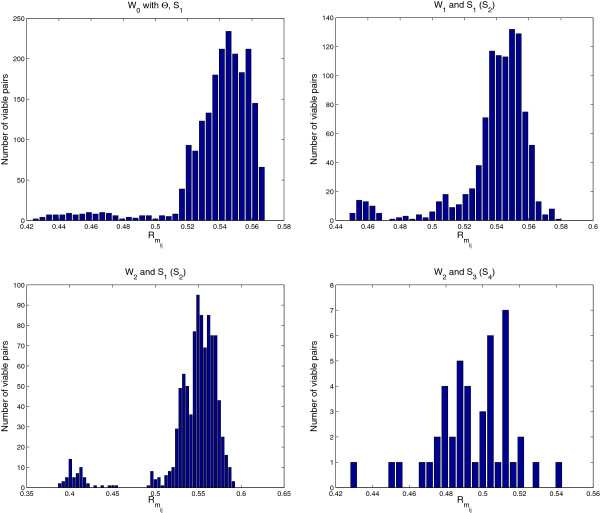
Distribution ofRmij for
W

1

,
W

2

, and
W

0

 with the
Θ
.